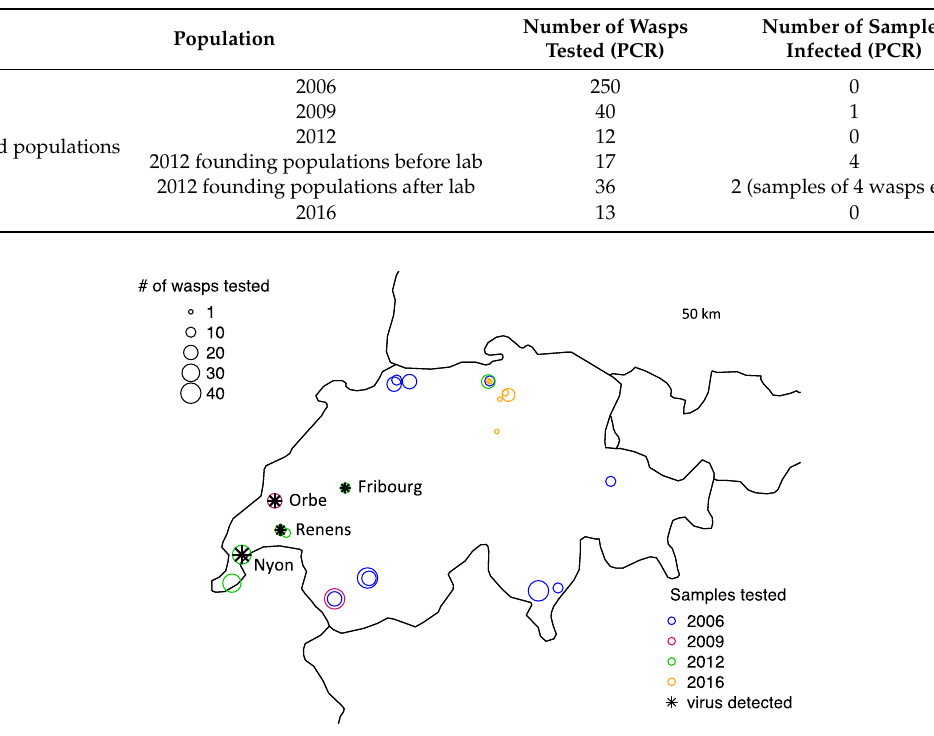
Figure 3. Swiss sampling sites where wasps were collected and tested for LysV (five additional sampling countries not shown). Viral presence was observed at four sites (shown by the asterisks), all in Western Switzerland. The samples were collected during different sampling events, indicated by the colors: 2006 (blue), 2009 (magenta), 2012 (green), and 2016 (orange). The area of the points correlates with the number of wasps extracted and tested for the virus. Viruses 2020 , 12 , x FOR PEER REVIEW